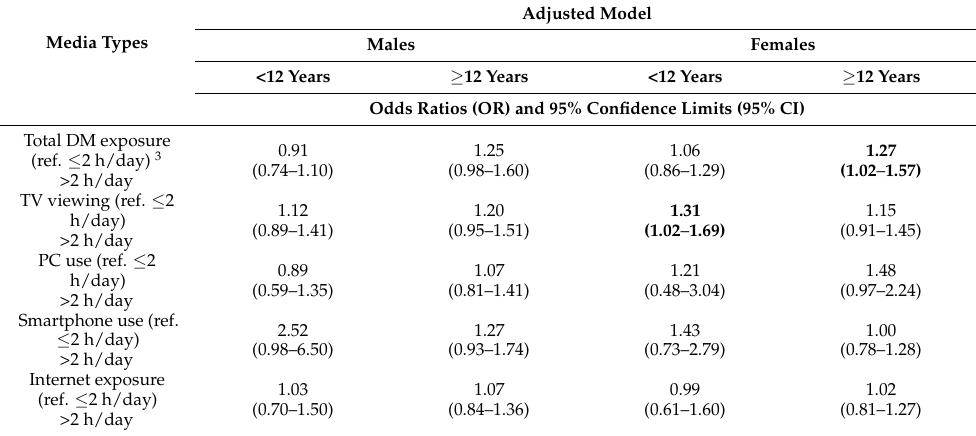
Table 2. Exposure to digital media in association with sweet taste preferences, stratified by sex and age group 1,2